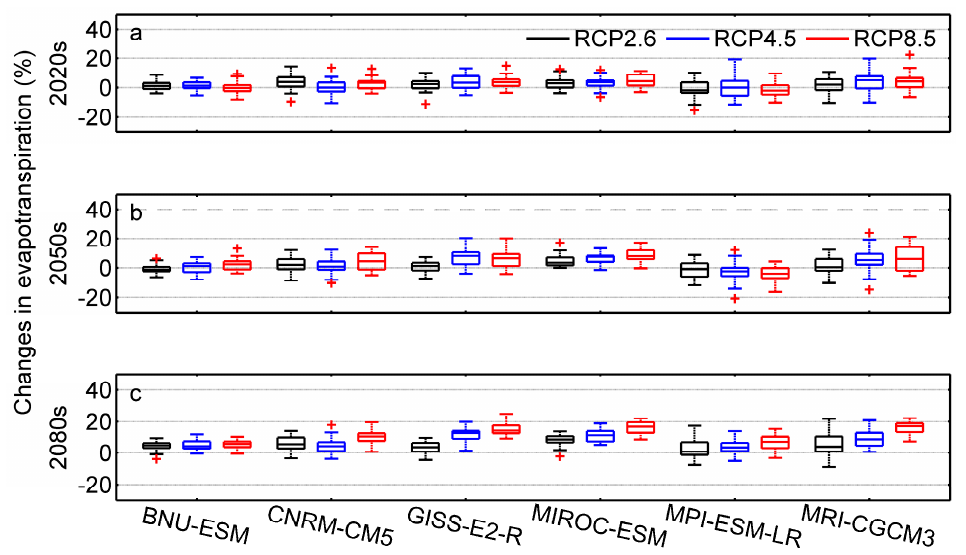
Figure 8. Box plots of change ratios in annual evapotranspiration (%) in the future periods (( a ) 2020s, ( b ) 2050s and ( c ) 2080s) under RCPs (RCP2.6, RCP4.5 and RCP8.5).